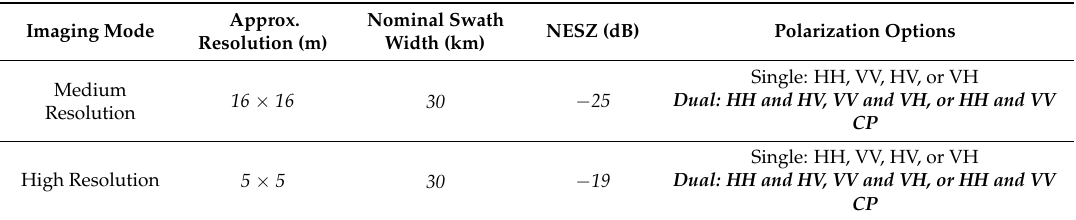
Table 1. Projected specifications of RCM imaging modes simulated in this research. Note that the specific polarizations evaluated here are bolded and italicized